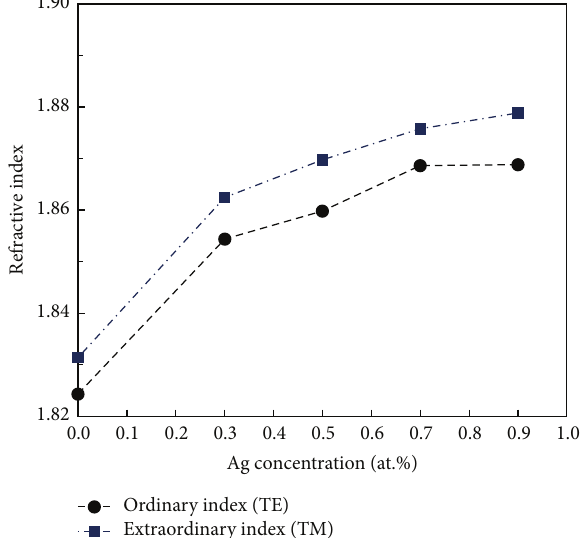
Figure 8: Ordinary and extraordinary refractive indexes of undoped and Ag doped ZnO thin